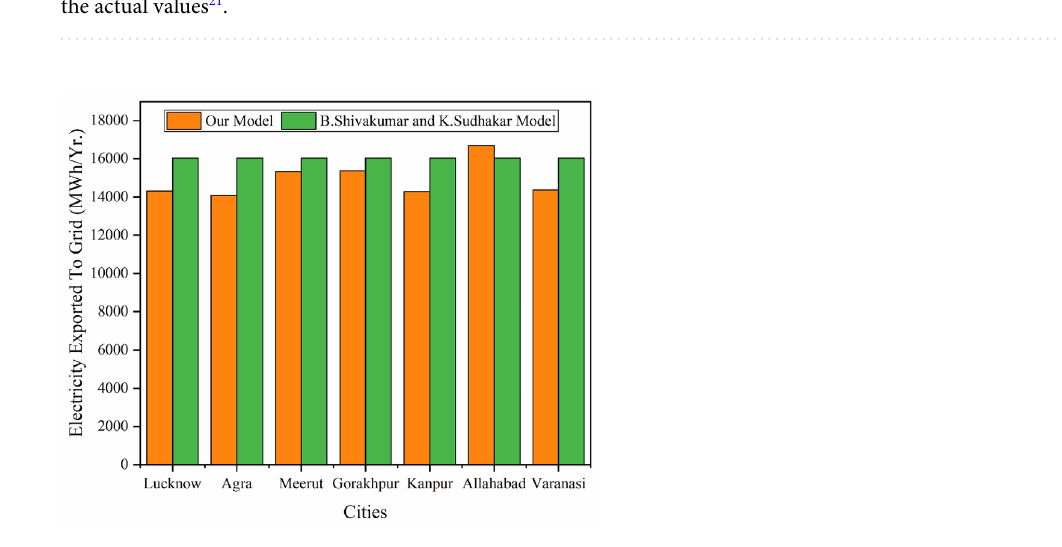
Figure 5. Validation of our simulated